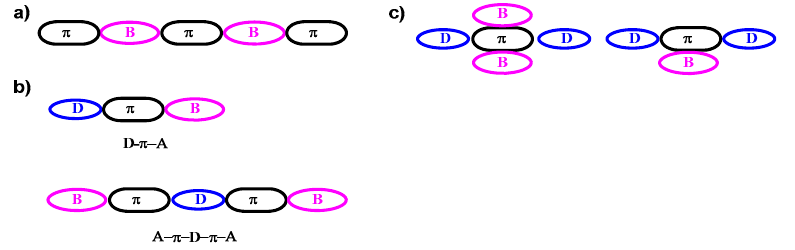
Figure 3. Schematic demonstration of π -conjugated D–A systems containing triarylborane groups ( a ) in the main chain; ( b ) at the terminal positions and ( c ) as a pendant in the side